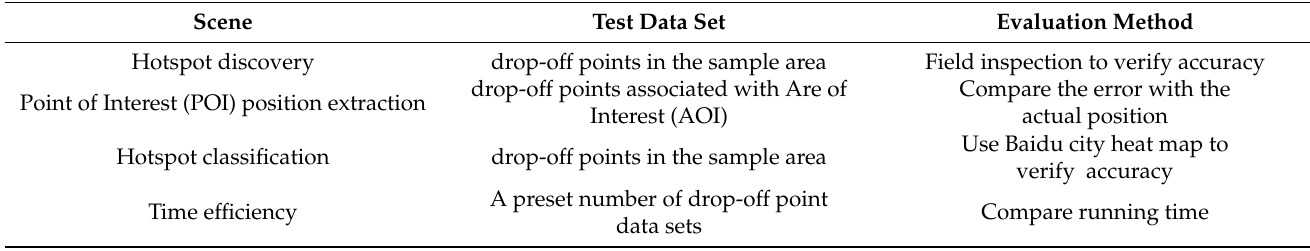
Table 3. Sample data and verification methods in each